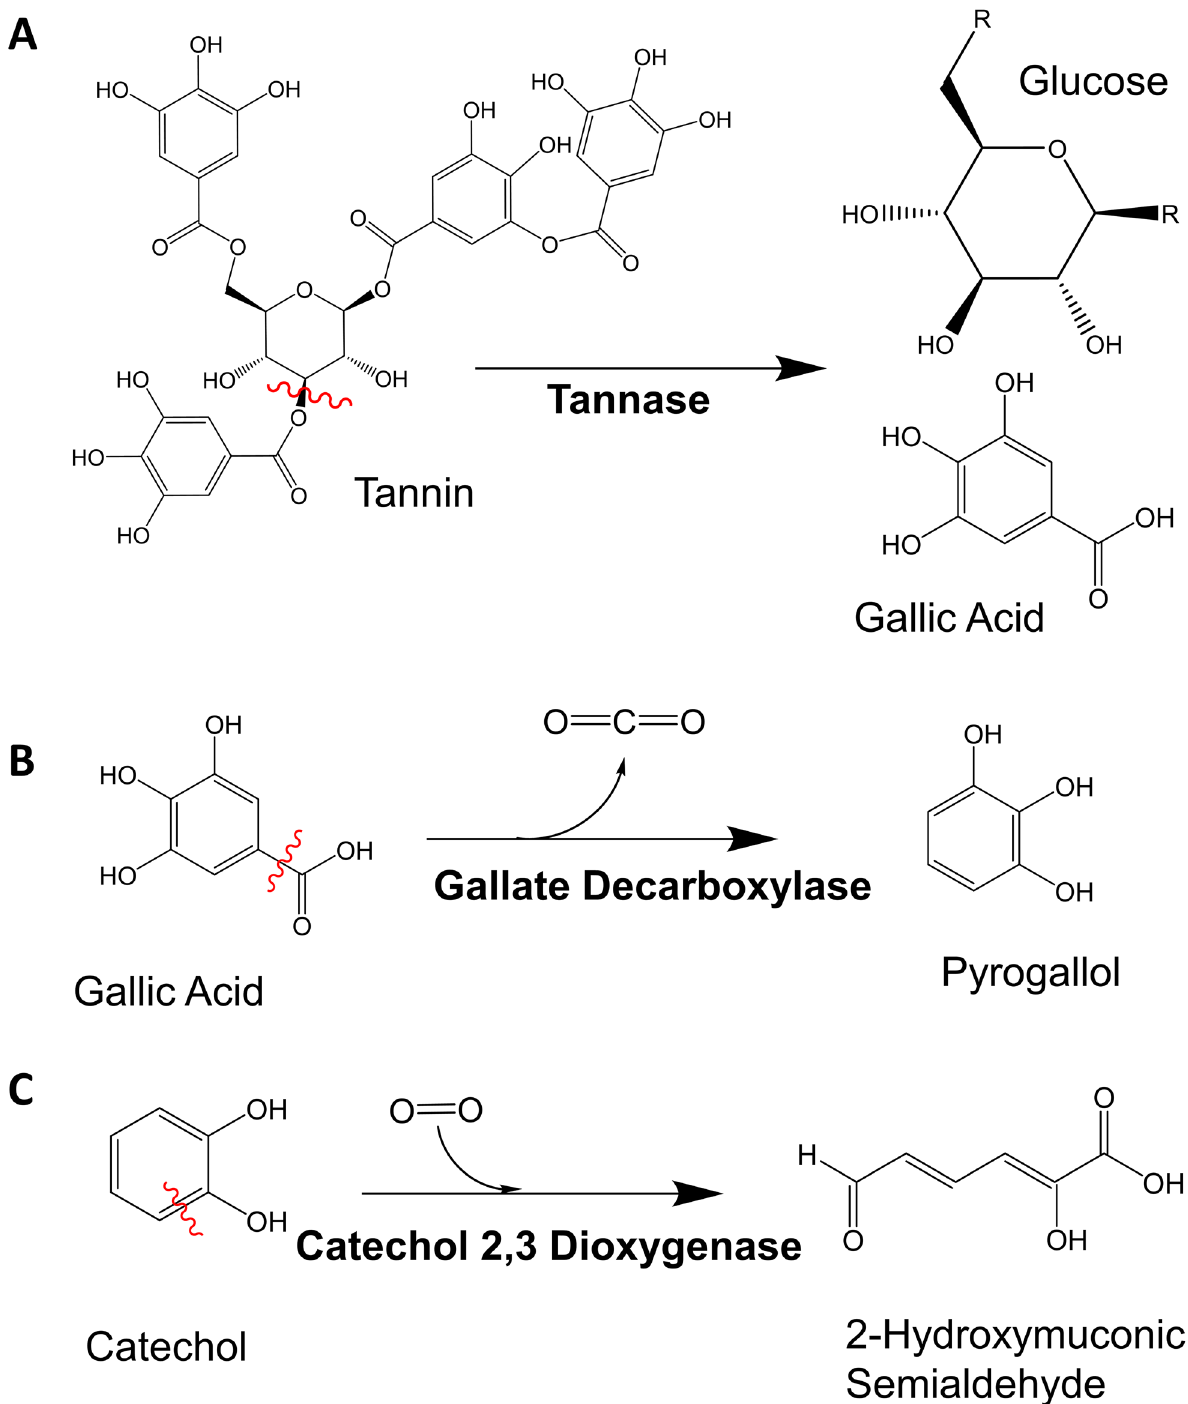
Fig. 1 Enzymatic reactions showing substrates and products relevant to this study. A tannase, B gallate decarboxylase, C catechol 2,3